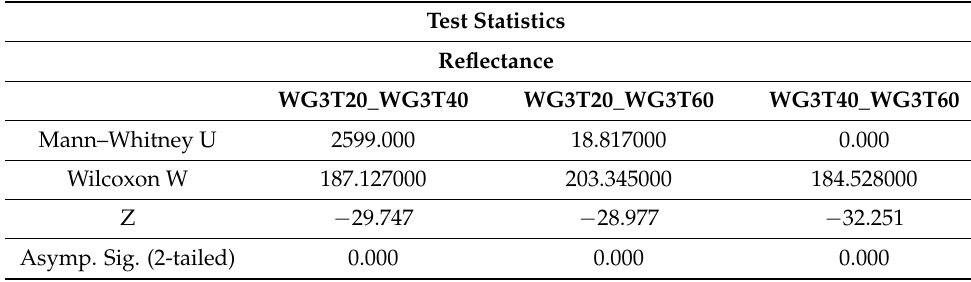
Table A20. Test statistics table of Mann–Whitney U test for specular solar reflectance of WG3 during the three holding